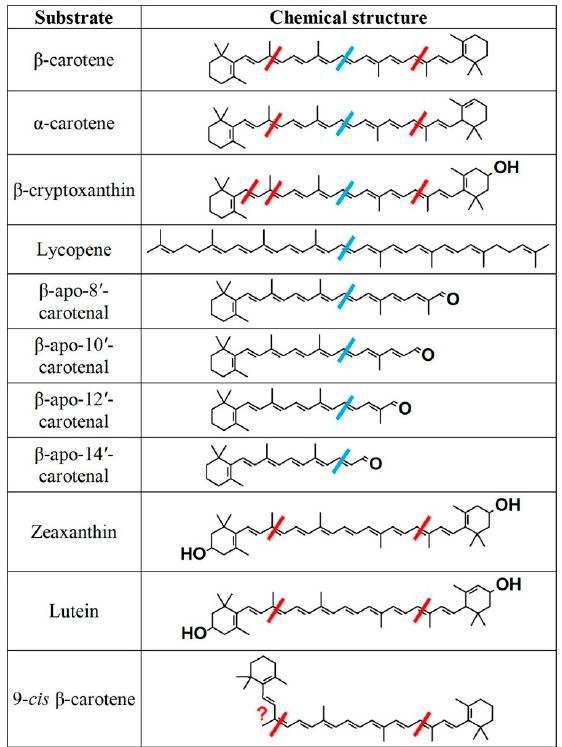
Figure 2. Structures of the substrates tested with purified recombinant chicken BCO2 and human BCO1. The red bars represent the cleavages observed with BCO2, and the blue bars, BCO1. Based on data from references [5,7] and used with permission from reference 10.